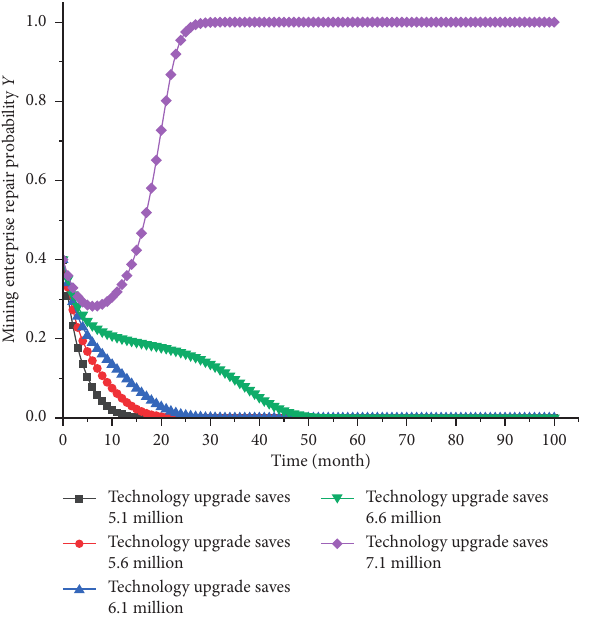
Figure 7: Impact of technology upgrade cost savings on mining companies’ strategic choices.